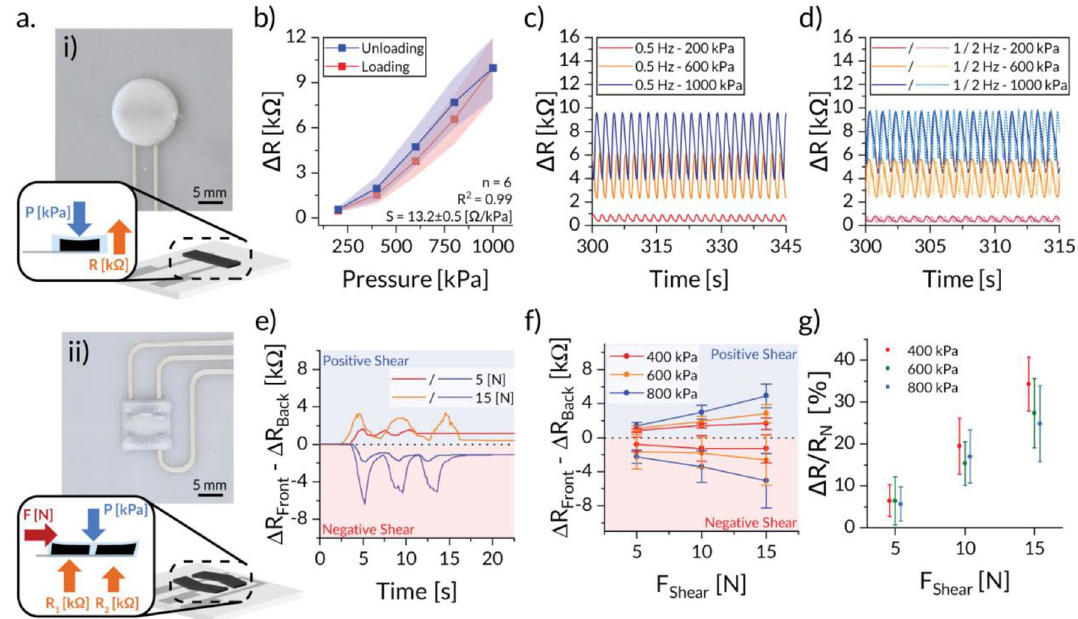
Figure 3. Piezoresistive sensors used to measure normal and shear forces. ( a.i,ii ) Images and schematics of the ( i ) normal and ( ii ) shear force sensors. ( b – d ) Responses in the form of change in resistance (∆R) of the normal sensor under ( b ) static, and ( c ) low-frequency or ( d ) high-frequency dynamic conditions. ( e , f ) Responses of the shear sensor in the form of the difference in resistance between front and back sensor as a function of ( e ) time and ( f ) applied shear force. ( g ) Sensitivity of the shear force sensor quantified in terms of normalized resistance change (%) under distinct normal and shear compression pressure. To show the effectiveness of our 3D printing approach, multiple sensors were manufac- tured and tested using a set of predetermined testing conditions. Responses of our normal force sensors were determined by applying load cases resembling human use equal to plantar pressures exerted during walking, running, and other sports activities 53,54 . The performance of the normal sensor to static loads was determined by measuring the change in resistance ( ∆R) 30 s after full loading for several sensors (n = 6) over a pressure range of 200–1000 kPa (Fig. 3b). The average static sensitivity of the sensors was found to be 13.2 ± 0.5 Ω/kPa or 0.22 ± 0.03%/kPa ( R 2 = 0.998) for this pressure range. The observed deviations in the peak response values can be attributed to a slight difference in baseline resistance ( R 0 ) between sensors, which had a value of 6.1 ± 1.4 kΩ (Figure S5). By calibrating for this baseline offset, the sensors can accurately sense plantar pressures for both low and high impact activities. The static responses were found to be stable over time after full load application in both the loading and unloading cases (Figure S6). From the experi- mentally measured resistance change of 8.2 ± 1.1 kΩ and the compression modulus of 9.2 ± 0.1 MPa (Figure S2d), we calculated the gauge factor (GF) of the normal force sensors to be 31.2 ± 0.1.